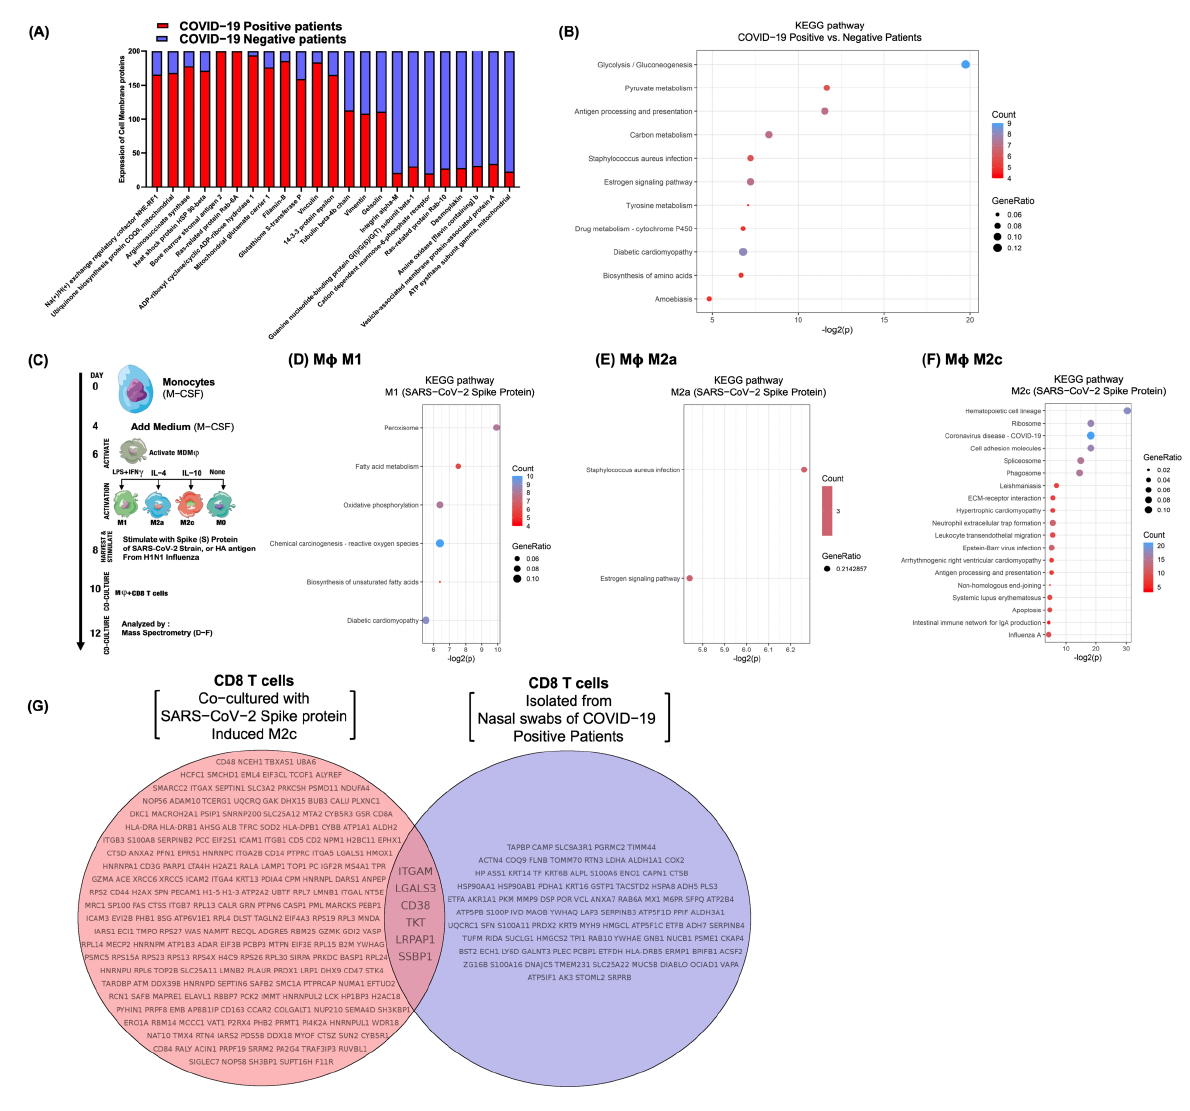
Figure 7. SARS-CoV-2 infection is exacerbated in the presence of M2c-type macrophages (M φ ), which lead to the activation or exhaustion of CD8 T-cells in COVID-19 patients. ( A ) Expression of cell membrane proteins on CD8 T-cells enriched from COVID-19-positive and -negative patients. ( B ) Proteomic alteration-associated pathways and diseases were studied based on KEGG pathway enrichment using the clusterprofiler package in R. Analysis was conducted on differentially expressed membrane proteins on CD8 T-cells enriched from COVID-19-positive versus -negative patients, after which significantly enriched KEGG pathways were identified. ( C ) The schematic diagram represents an in vitro model of macrophage (M φ ) cells co-cultures and stimulation conditions. Data in each experimental condition represents a co-culture of eight individual donors (M φ co-cultured with PBMCs/T-cells/CD8 T-cells). ( D – F ) KEGG pathway analysis shows significantly enriched pathways associated with differentially up- and down-regulated proteins on CD8 T-cells in the presence of (D) M1 macrophage conditions with the SARS-CoV-2 S protein, ( E ) M2a macrophage conditions with the SARS-CoV-2 S protein, and ( F ) M2c macrophage conditions with the SARS-CoV-2 S protein. KEGG-based enrichment analysis of DEPs (two-sided hypergeometric test; p < 0.05) and the number of counts (count > 2). KEGG terms were sorted by adjusted p values using the Benjamini–Hochberg method. ( G ) Comprehensive comparative protein analysis of in vitro CD8 T-cells co-cultured with trimer S protein-stimulated M φ subset, M2c, and CD8 T-cells from NP samples of COVID-19-positive patients. Venn diagram shows the shared proteins among differentially expressed